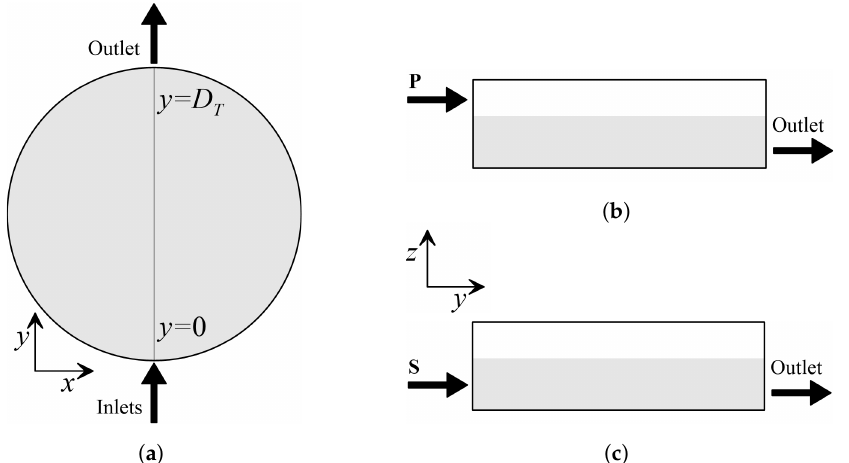
Figure 3. Inlet–outlet configuration–schematics: ( a ) top view; ( b ) plunging jet (P); and ( c ) submerged jet (S).